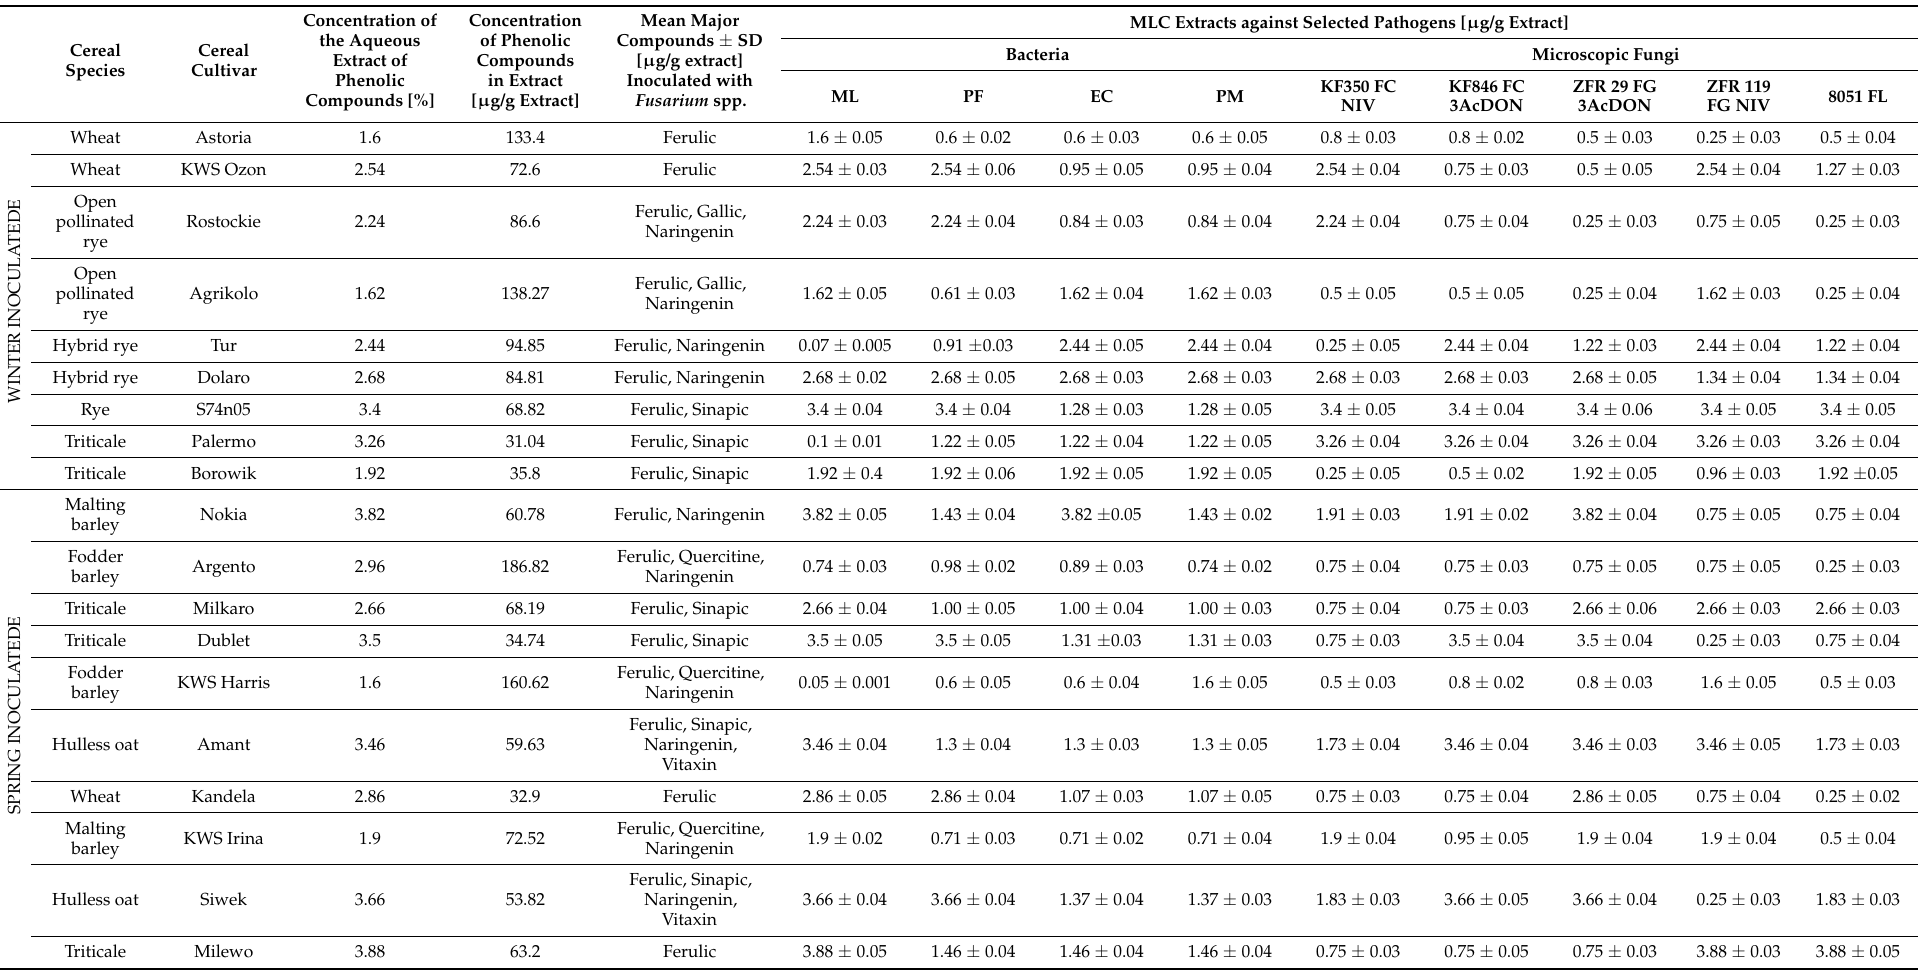
Table 3. Concentrations [%] of extracts of phenolic acids coming from selected cereal genotypes grown in Poland and Minimum Lethal Concentration (MLC) of extracts against selected bacteria (ML, PF, EC, PM) and microscopic fungi ( Fusarium